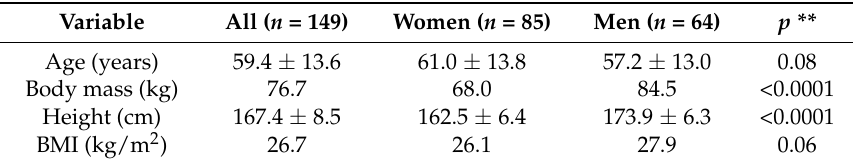
Table 1. Study group characteristics * ( n = 149).